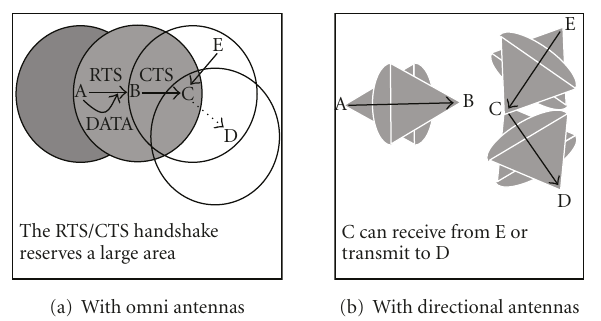
Figure 3: The hidden terminal problem.